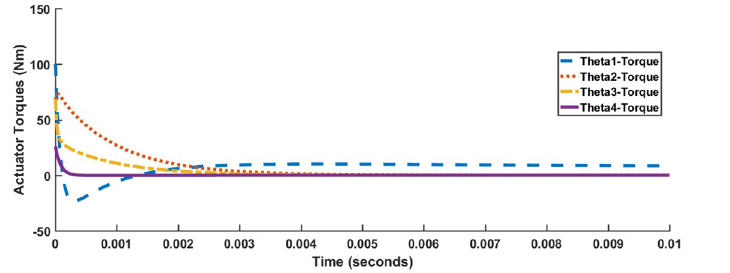
response and actuator torque profiles of Case I and Case II are similar, only the plots of Case I have been shown. It is evident from both Figs 7 and 8 that not only has the steady-state error been removed but also less control effort is expended. The degradation in transient parameters